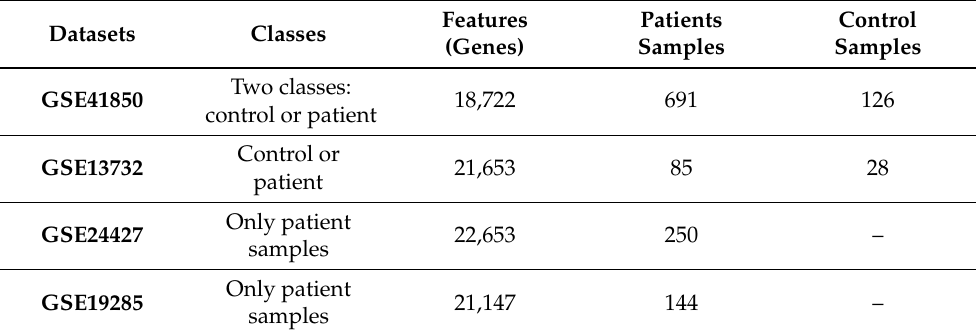
Table 1. MS datasets’ description.